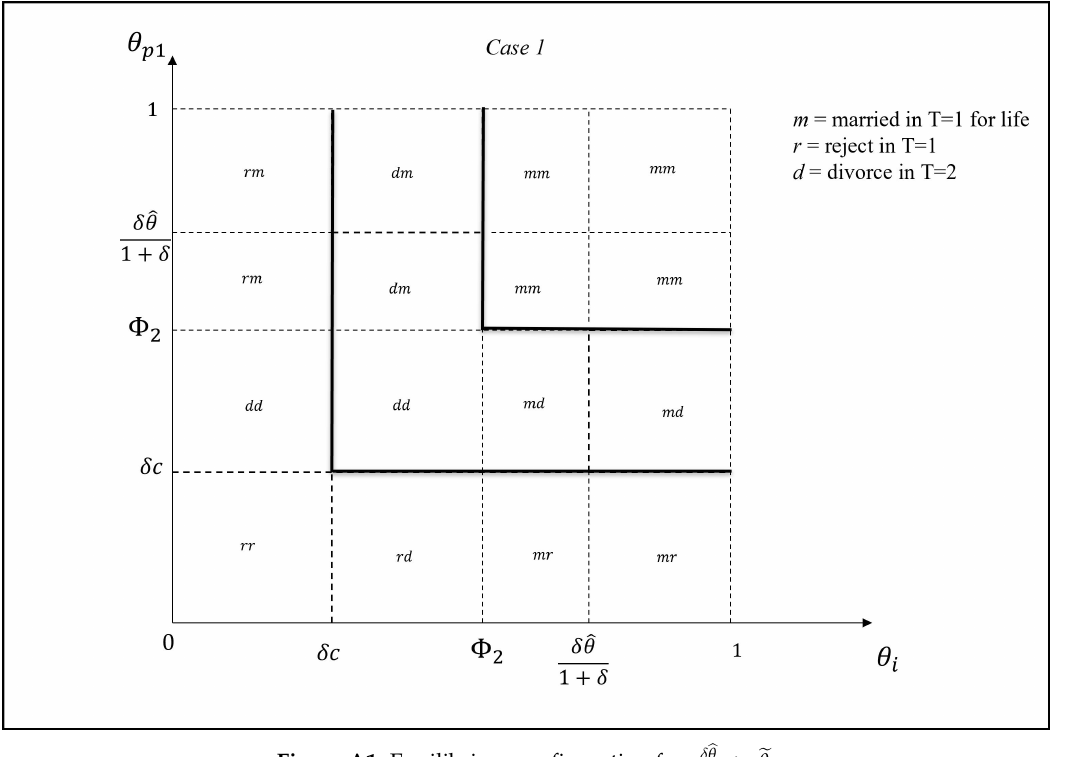
Figure A1. Equilibrium configuration for δ (cid:98) θ